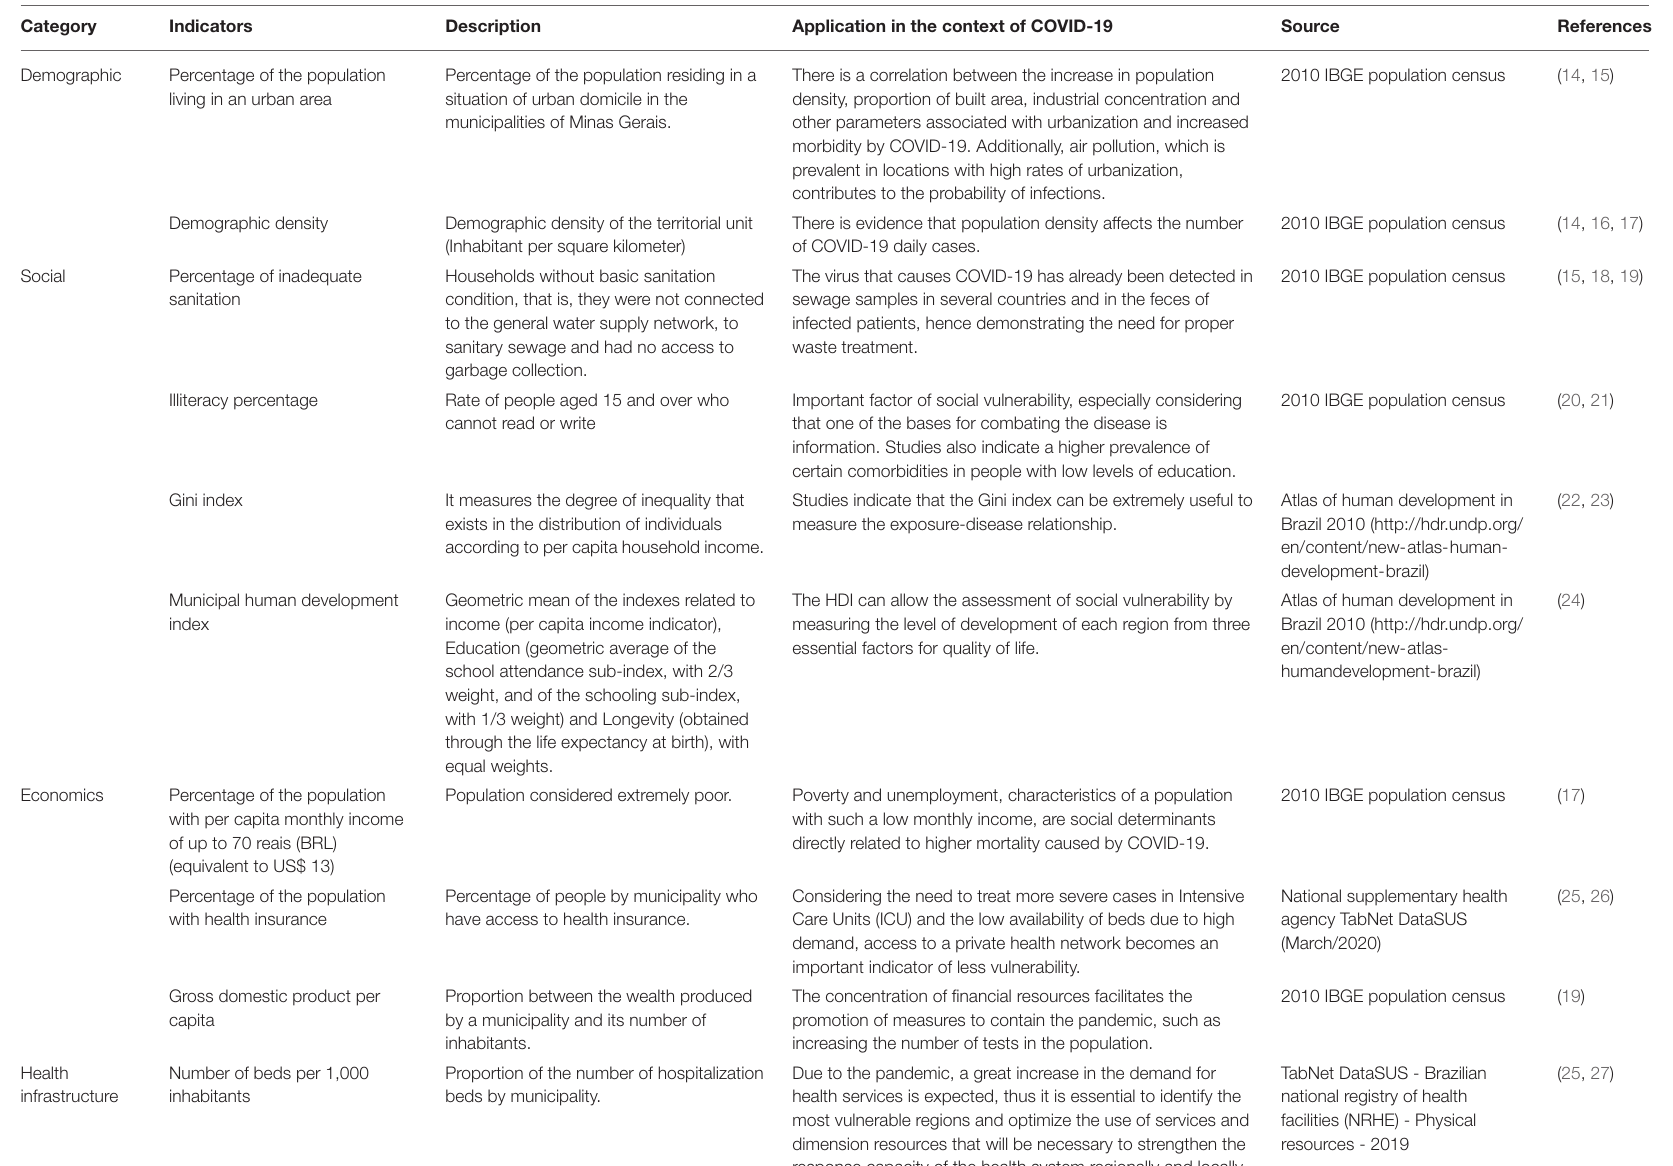
TABLE 1 | Indicators by category (demographic, social, economic, health infrastructure, population at risk, epidemiological) used in the Multi-criteria Decision Analysis (MCDA) to assess the vulnerability of the municipalities of Minas Gerais to